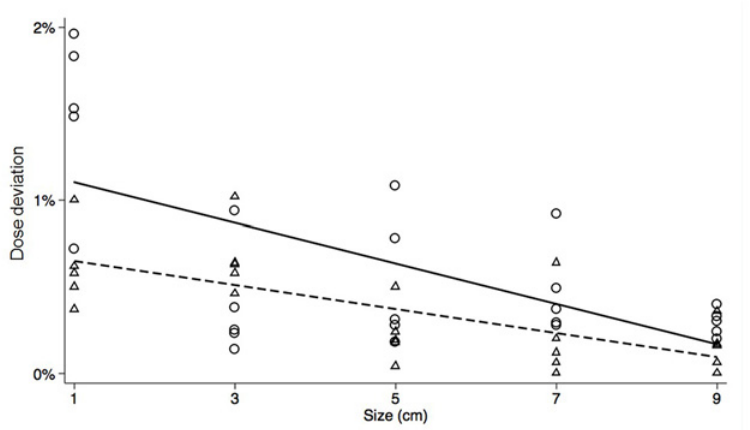
Fig 2. The dose deviation of the isocenter between the 3DVH-predicted dose and the treatment planning system (TPS)-planned dose is plotted as a solid line. The dashed line represents the dose deviation between the ion-chamber measured isocenter dose and planned dose. The dose deviations decreased with increasing target size.